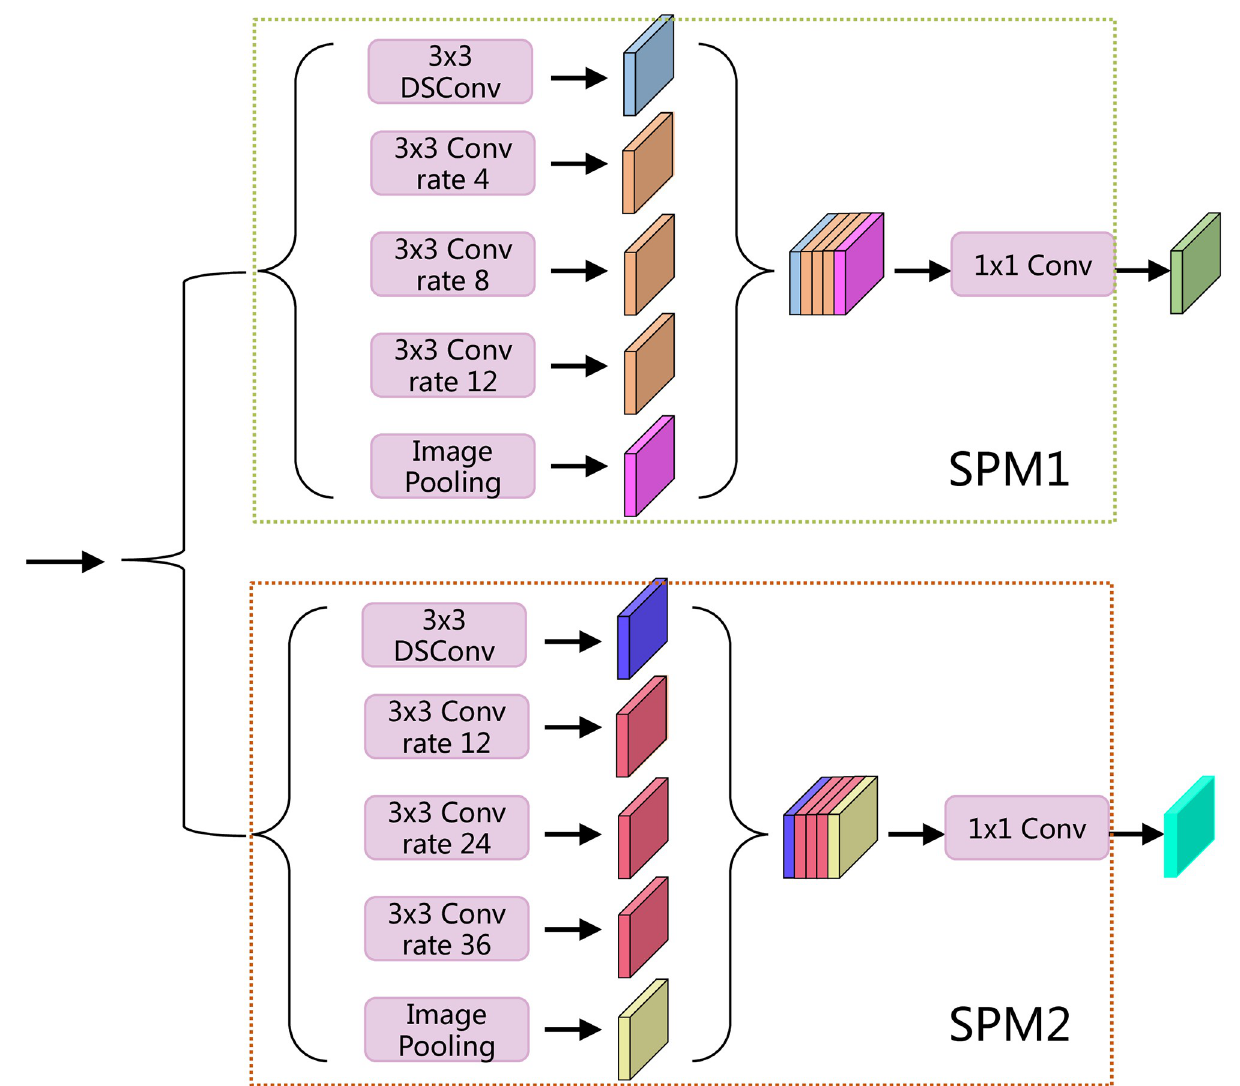
Fig 2. Double Spatial Pyramid